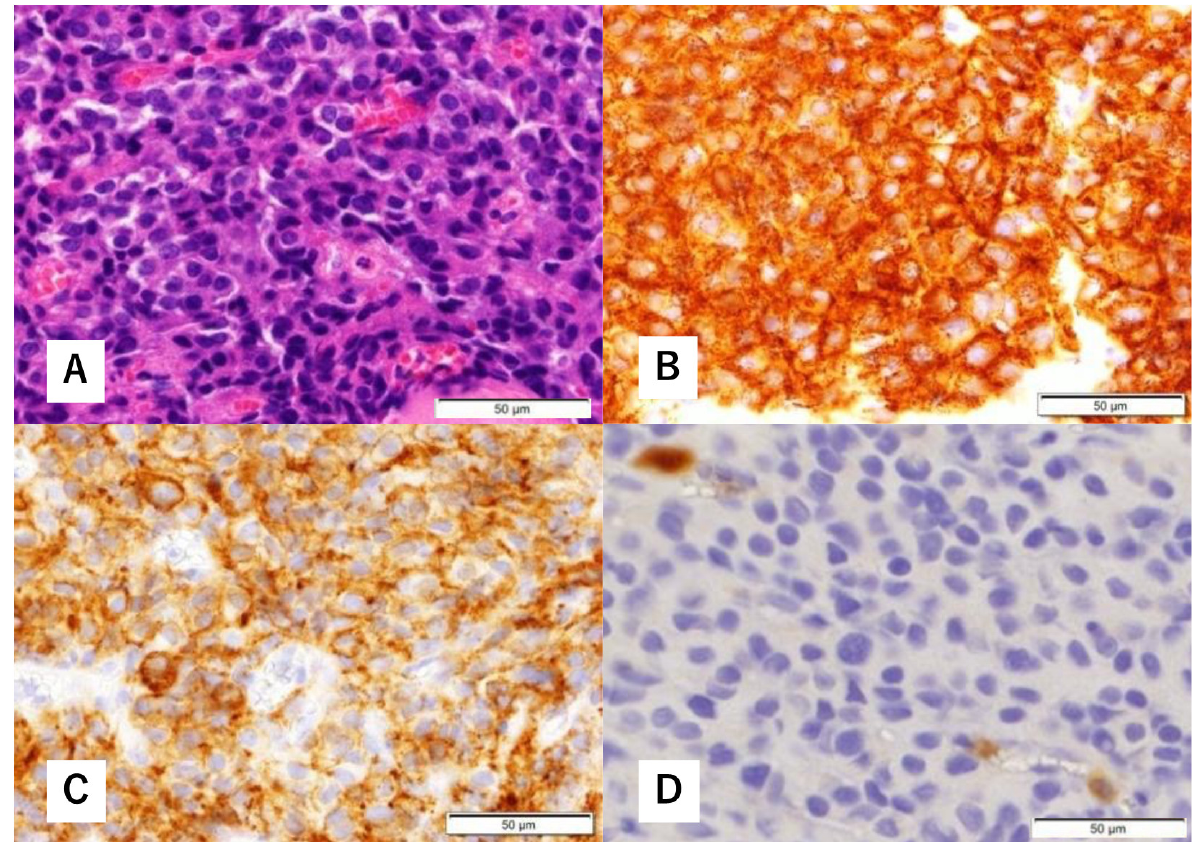
Figure 3. Histopathological findings of biopsy specimens. Hematoxylin-eosin (H&E) staining shows focal proliferation of atypical cells with a high nucleocytoplasmic (N/C) ratio ( A ). Immunohistological staining is positive for synaptophysin ( B ) and cluster of differentiation (CD) 56 ( C ). There are a few S-100 protein-positive cells ( D ).